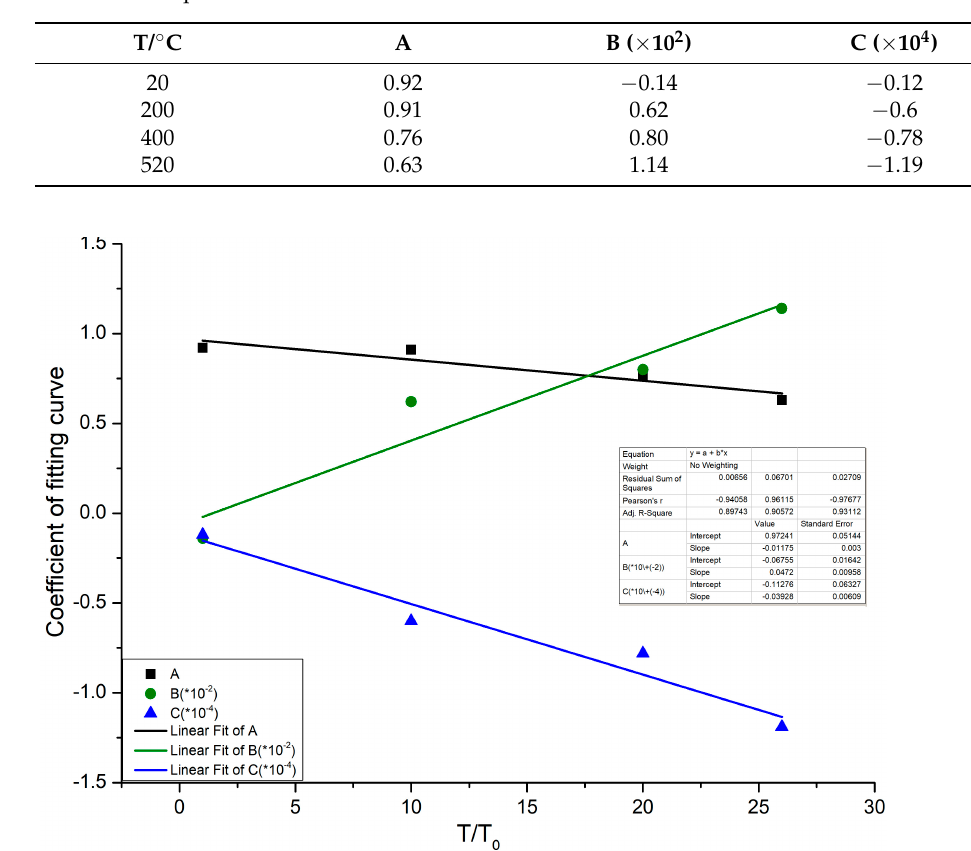
Table 6. Fitted parameter values.